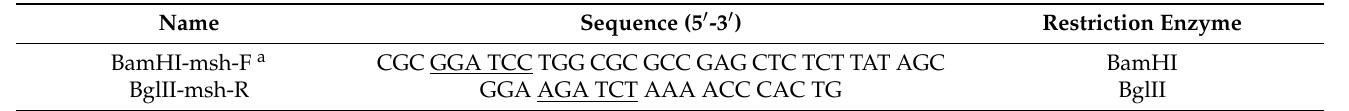
Table 1. The primers used in this study.